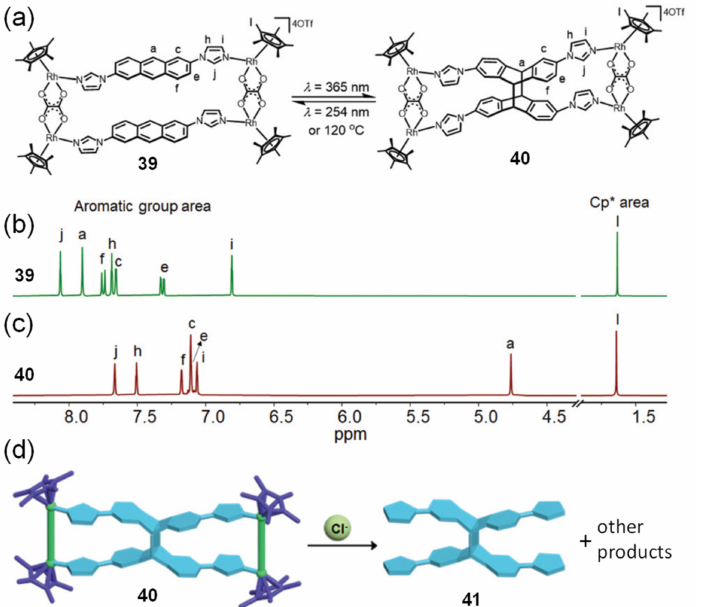
Figure 9. Stimulus-responsive rhodium-based metallarectangles. ( a ) Photochemical [4 + 4] cycload- dition of 39 and reversible transformation. ( b , c ) Partial 1 H NMR spectra in CD 3 CN of ( b ) 39 and ( c ) 40 . ( d ) Schematic representation of the dissociation of 40 into 41 . Reprinted with permission from Ref. [82]. Copyright 2022 Royal Society of